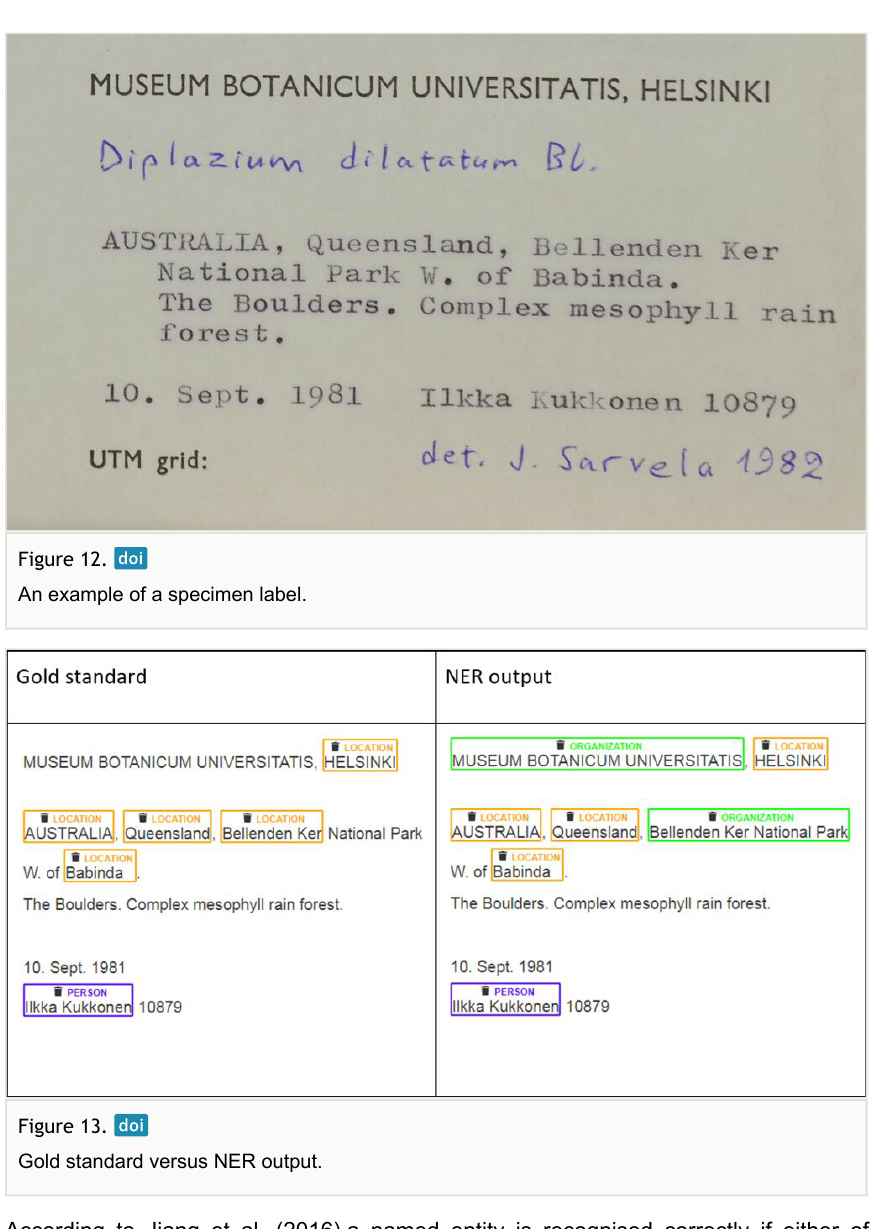
1. Both boundaries of a named entity and its type match. For example, the segment “Ilkka Kukkonen” in Fig. 13 is recognised fully and correctly as a person. 2. Two text segments overlap partially and match on the type.